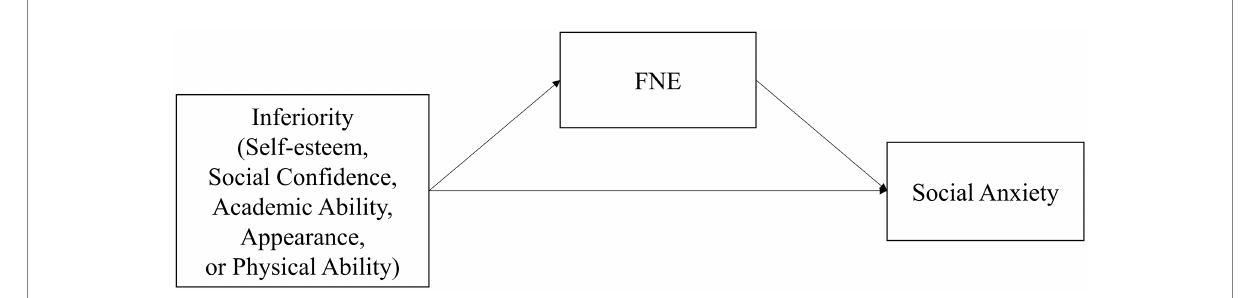
FIGURE 1 Hypothesized research model. FNE = fear of negative